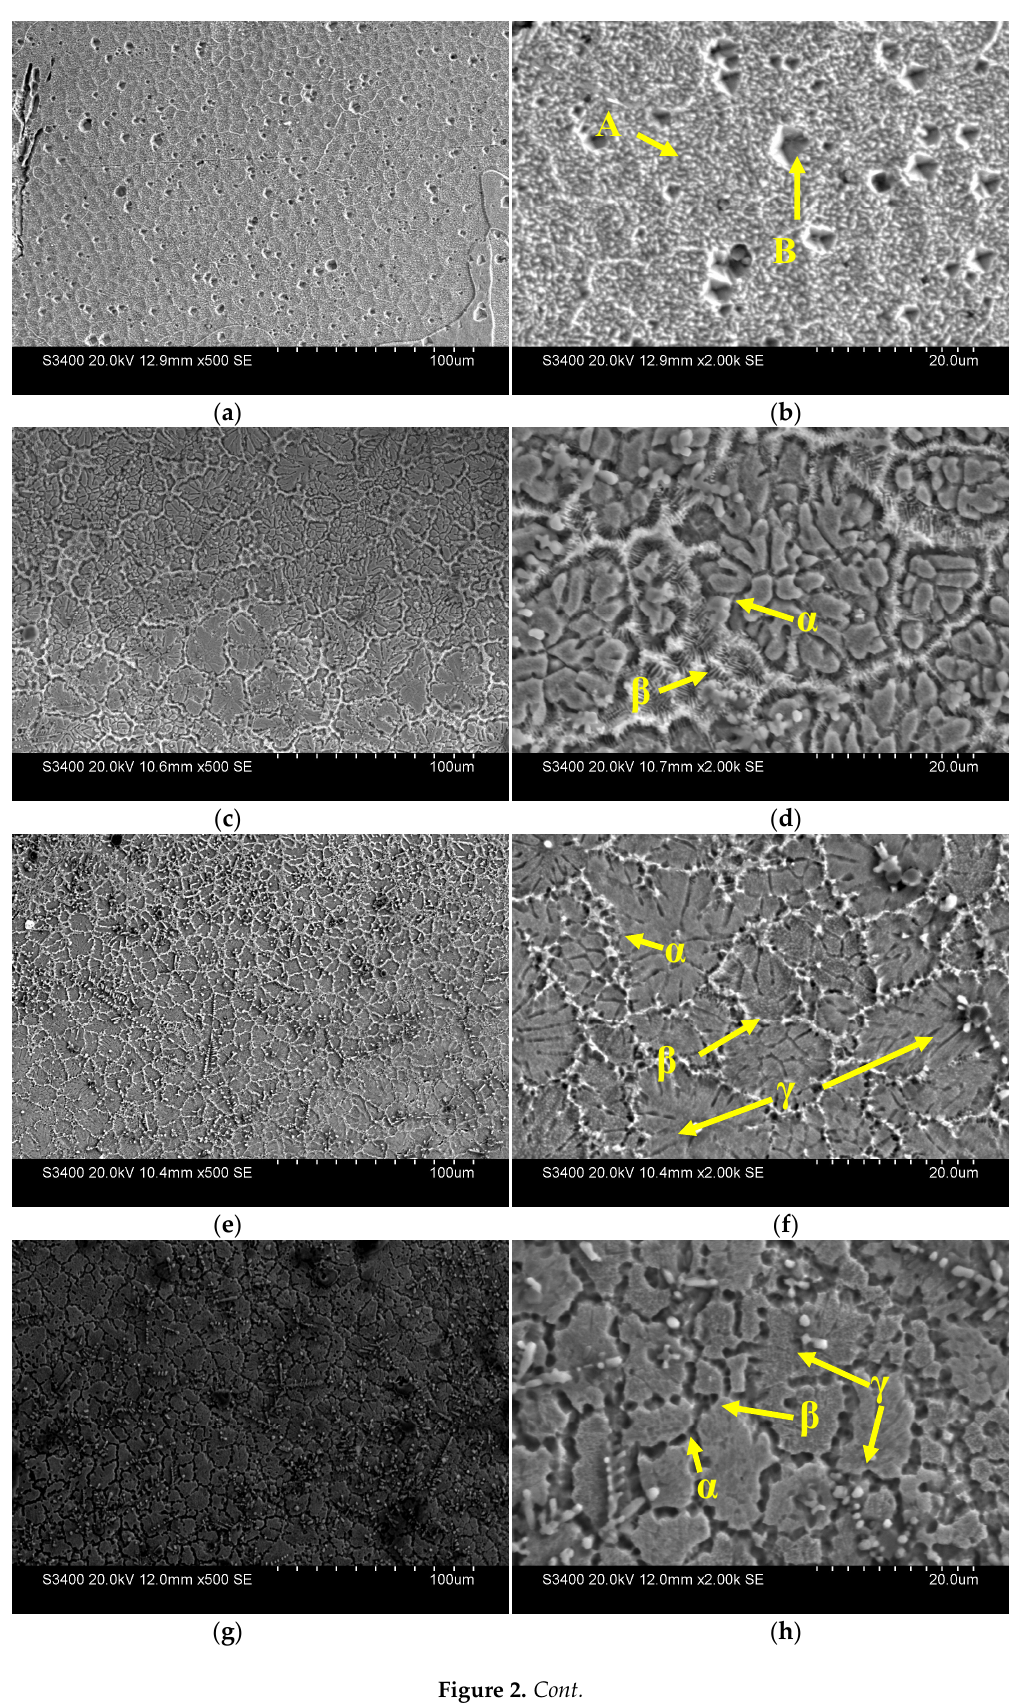
Figure 2. Cont. Figure 2.